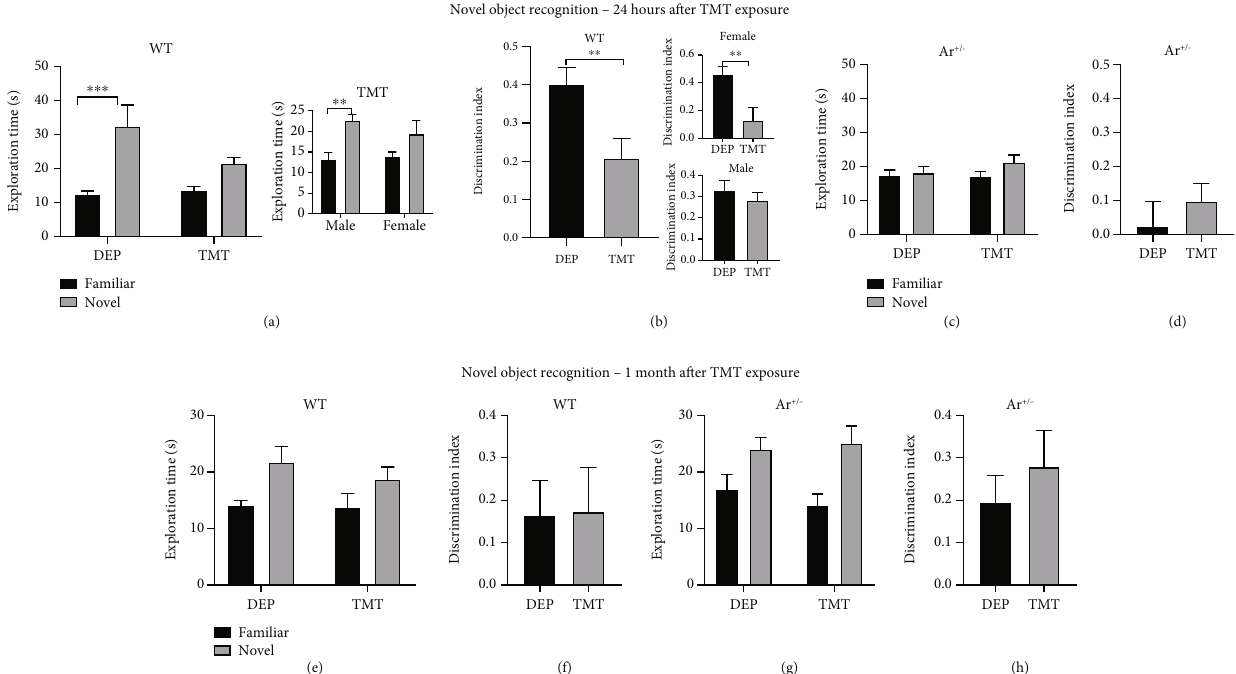
Figure 2: TMT-induced acute and chronic changes in the novel object recognition test in WT mice and Ar+/- mice. WT mice showed shorter time spent in exploring the novel object (a) and lower discrimination index (b) 24h after TMT exposure, particularly in females, while the Ar+/- mice showed genotype-speci fi c impairment of preference to novel object 24 h after TMT exposure (c, d). One month after TMT exposure, there were no signi fi cant di ff erences between the DEP group and TMT group in the exploration time and discrimination index in the WT mice (e, f) and Ar+/- mice (g, h), respectively. Data are shown as mean ± SEM . ∗ P < 0 : 05 , ∗∗ P < 0 : 01 , and ∗∗∗ P < 0 : 001